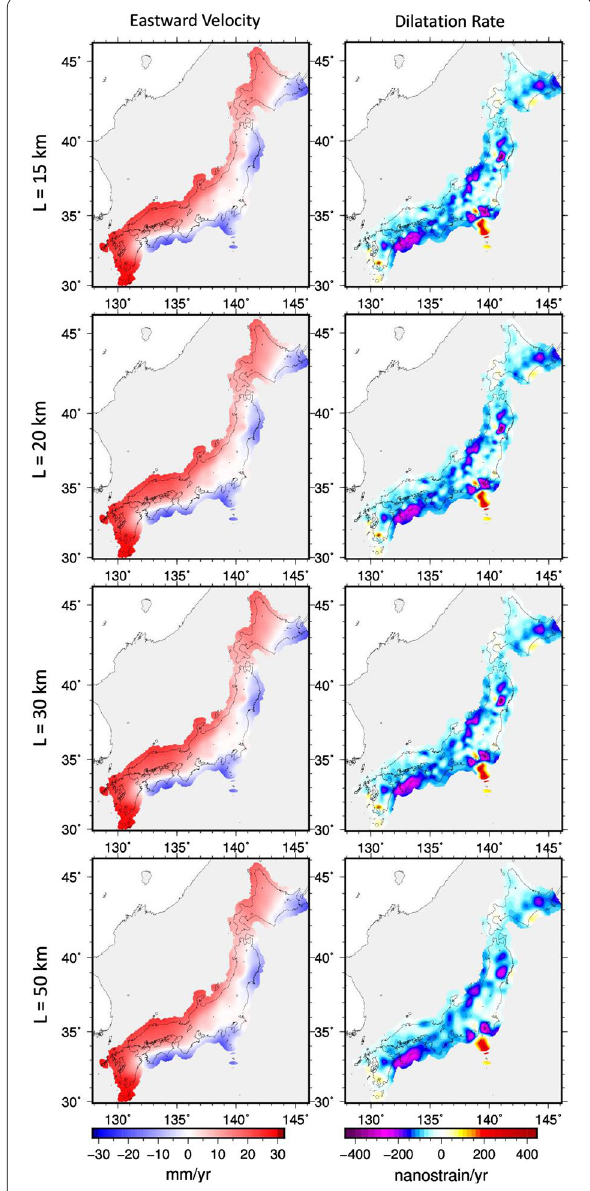
Fig. 8 Comparison of the estimated eastward velocity and dilatation-rate fields in the ABIC method. Results of the different values of the basis-function interval L are